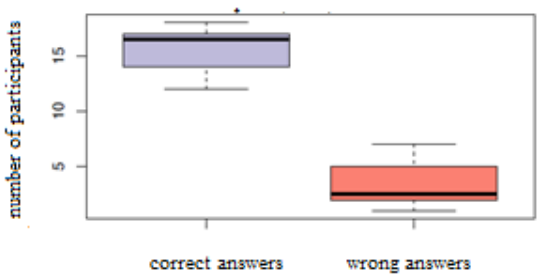
Figure 5 . Boxplot for complement sentences